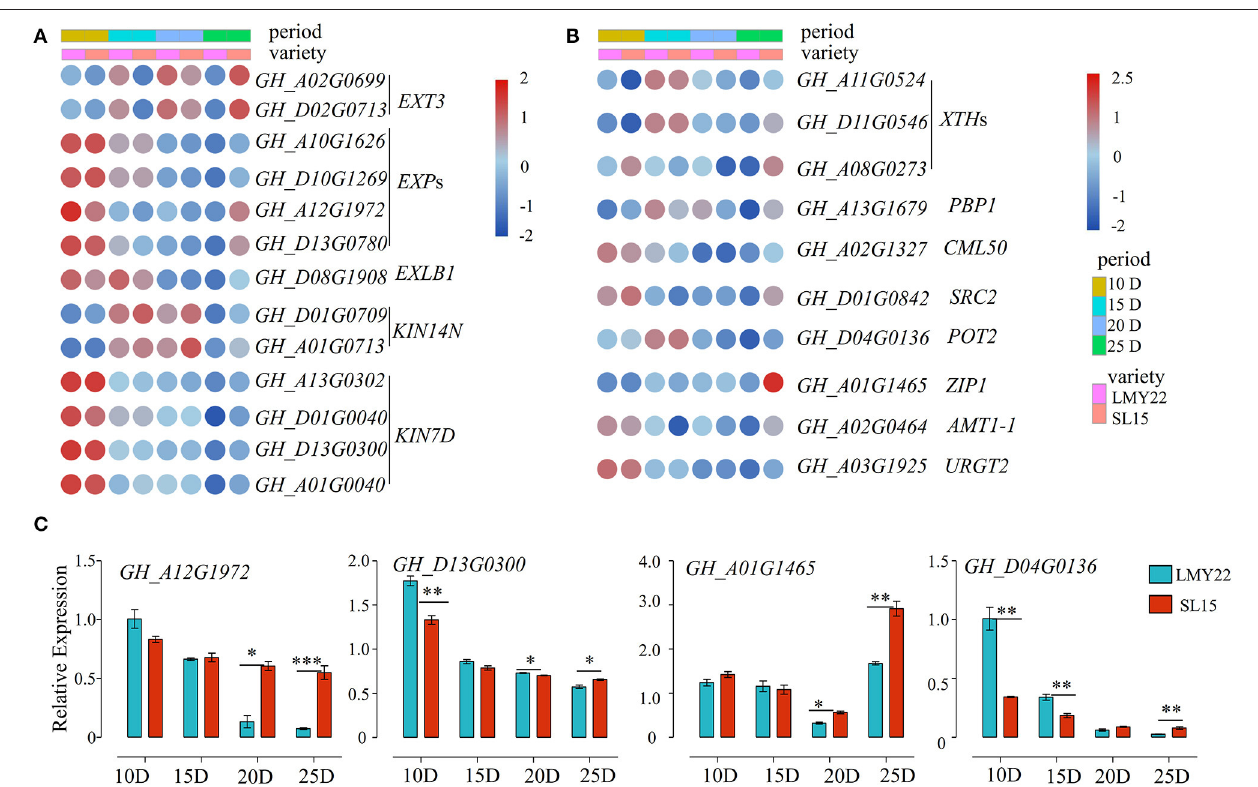
FIGURE 4 | Expression patterns of genes related to fiber elongation. Heat map for DEGs involved in (A) cell expansion and (B) cell wall loosening. (C) Expression of four DEGs as determined by qRT-PCR. * P < 0.05, ** P < 0.01, and *** P < 0.001.